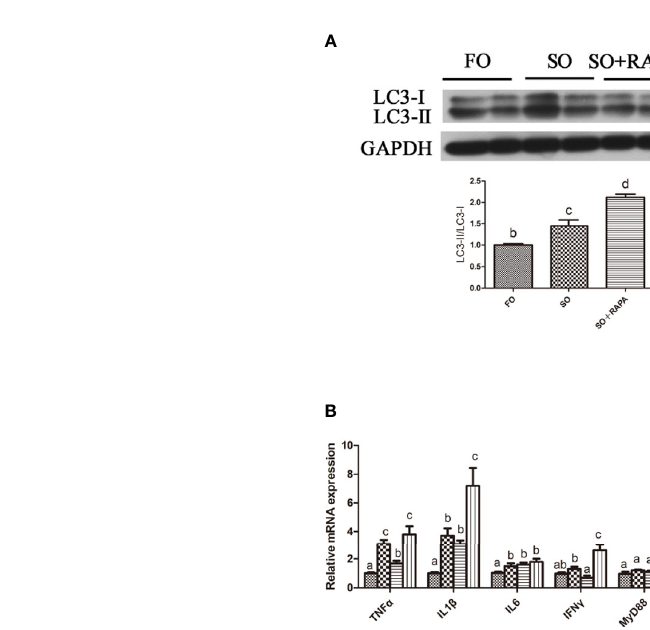
FIGURE 5 | Autophagy could reduce SO-induced in fl ammatory in vivo . (A) The ratio of LC3-II/LC3-I was analyzed by western blots on liver after treatment of FO, SO, SO+RAPA and SO+CQ (n=3). FO group as a negative control. (B) The mRNA expressions of TNF a , IL1 b , IL6, IFN g , MyD88, Cox-2, IL10 and Arg I were analyzed by qRT-PCR on liver after treatment of FO, SO, SO+RAPA and SO+CQ (n=6). Results were represented as means with SEM and signi fi cance was evaluated by one-way ANOVA followed by Tukey ’ s multiple range tests ( P < 0.05). a,b,c Means share a same superscript letter are not signi fi cantly different ( P ≥ 0.05).